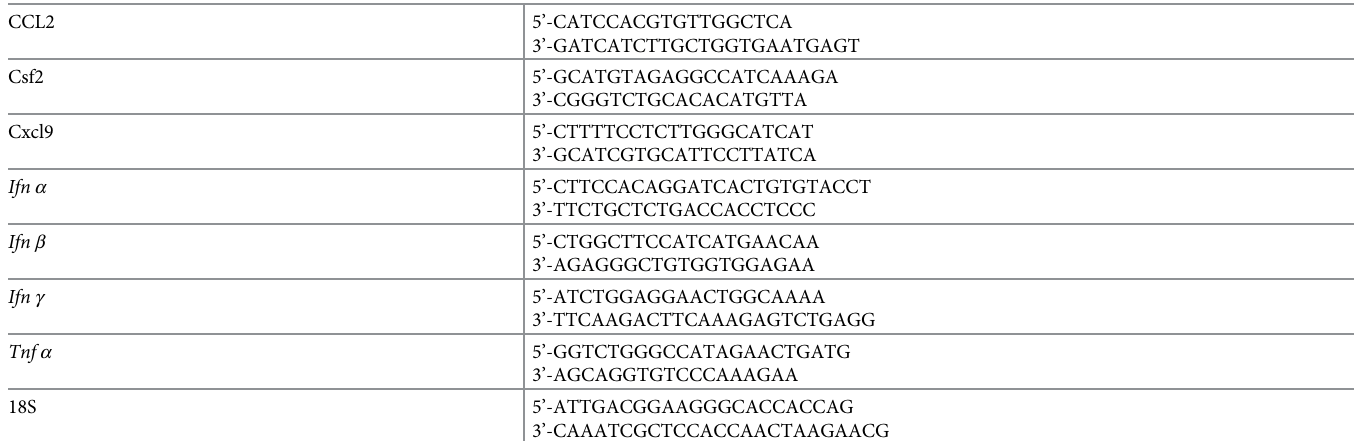
Table 1. List of